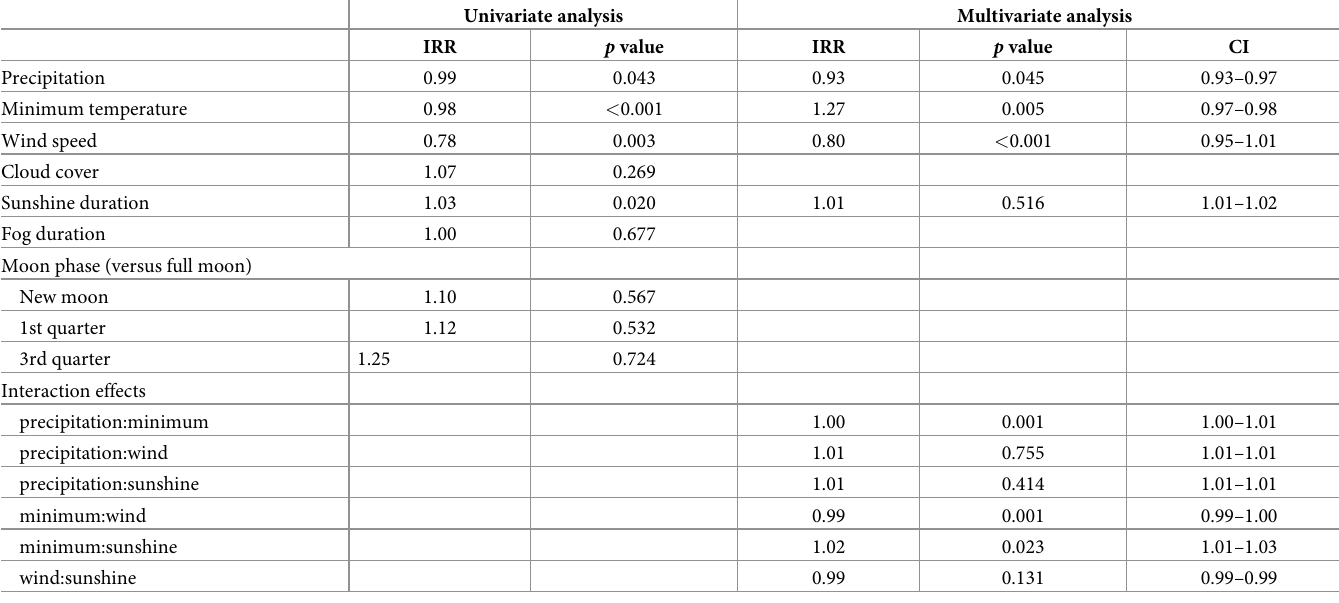
Table 2. Multivariate regression analysis of relationships between weather factors and moon phase with fall injuries in metropolitan